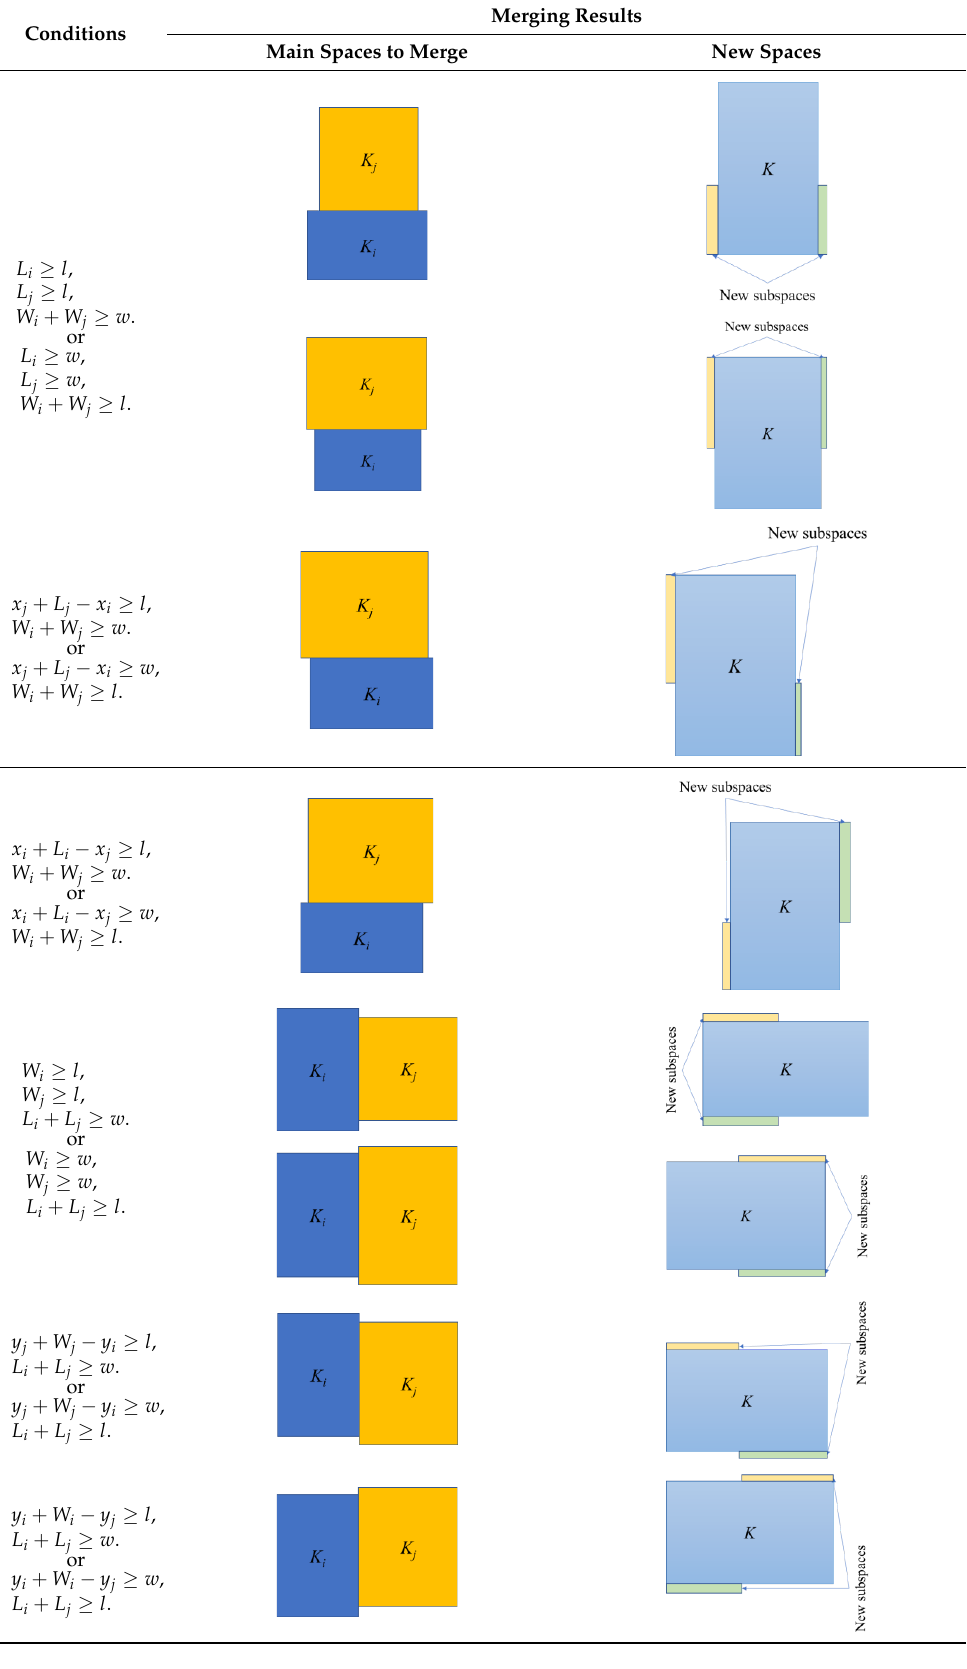
Table 1. Merging the main spaces to find the fitted space. Merging Results Conditions Main Spaces to Merge New Spaces